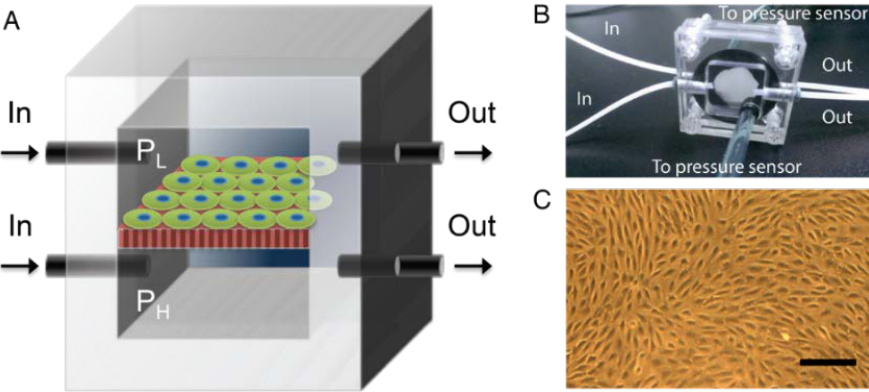
Figure 1. Overview of the microfluidic platform. ( A ) Schematics of the device where podocytes were cultured on porous membrane, which was sandwiched by an upper chamber supplying P L and a lower chamber supplying with P H . The pressures in both chambers were controlled by peristaltic pumps that infused the medium via the inlet and outlet and monitored by pressure sensors. ( B ) An image of the real device; ( C ) a microscopic image of the differentiated podocytes monolayer. Scale bar, 50 μm.